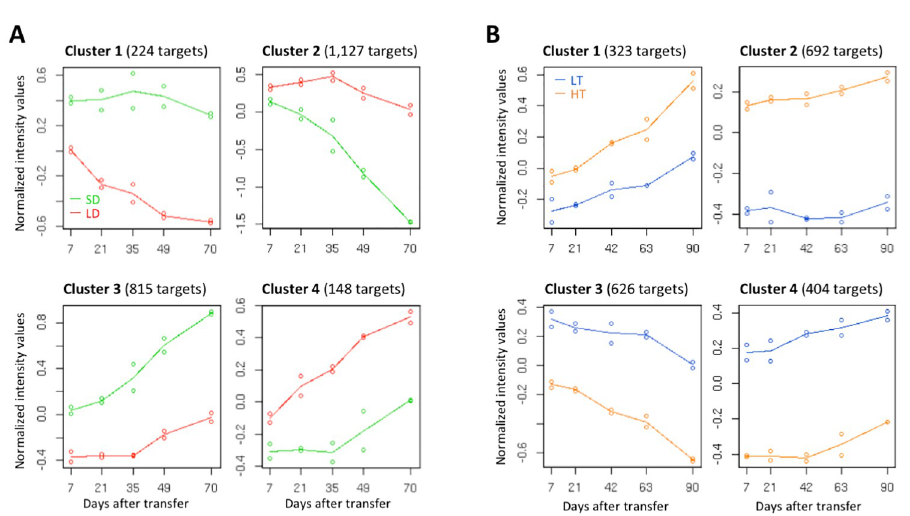
Fig 3. Expression pattern of a cluster of targets regulated by day length and temperature. (A) Median profile of four clusters of SD-regulated targets under LD and SD conditions (red and green, respectively). (B) Median profile of four clusters of LT-regulated targets under HT and LT conditions (orange and blue,